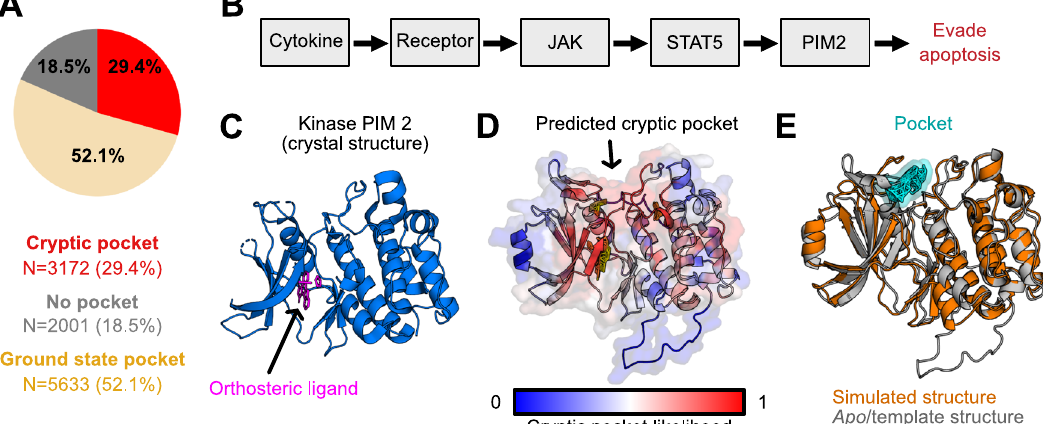
Fig. 6 | Applying PocketMiner across the human proteome reveals thousands of cryptic pockets. A Though nearly half of proteins lack a pocket in their native, folded state, the majority of these proteins are predicted to have a cryptic pocket. Pie chart shows the number of human proteins containing pockets in their native structures in wheat; proteins that lack pockets in their native structures but are likelytoformcrypticpocket(s)inred;andproteinsthatlackbothgroundstateand cryptic pockets in gray. B Schematic showing proteins involved in the